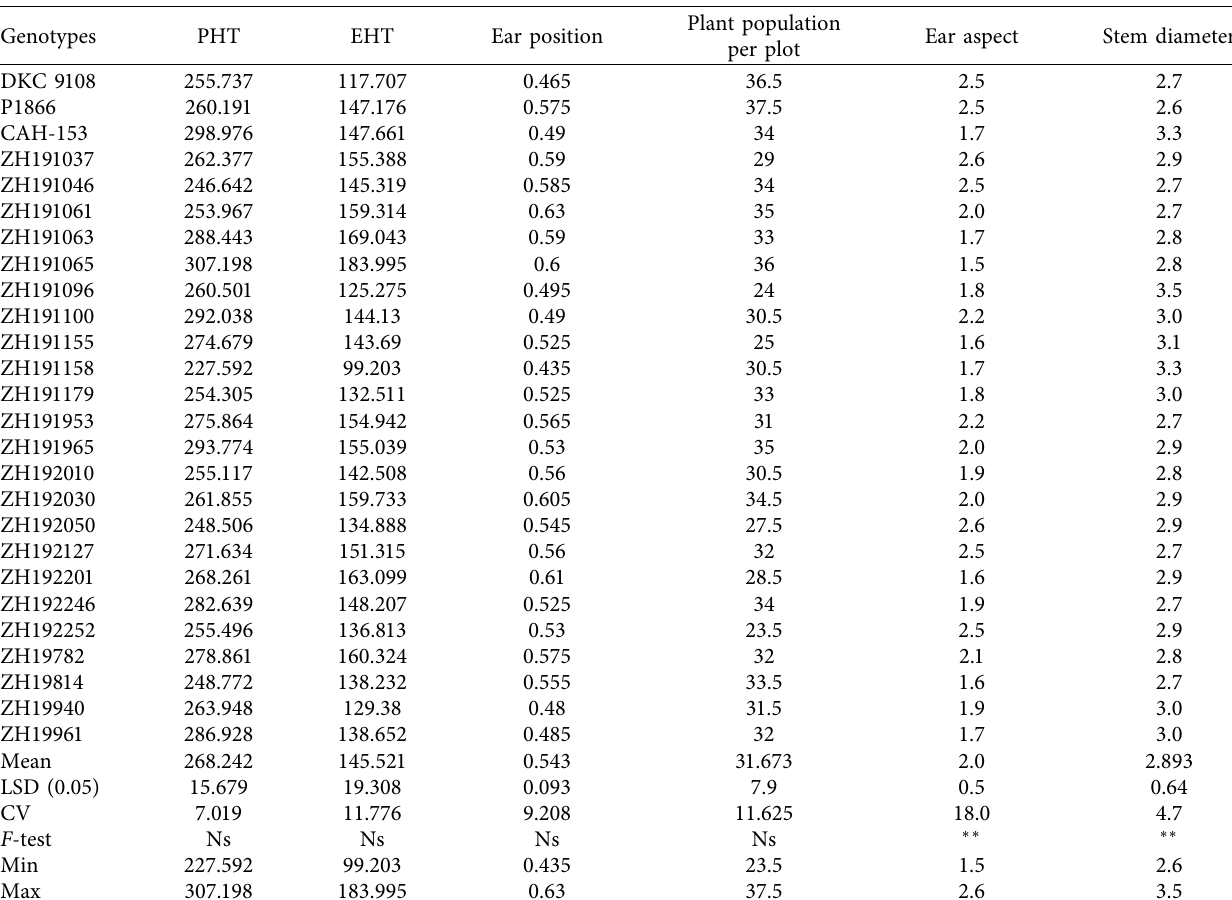
Table 3: Average performance of plant architectural